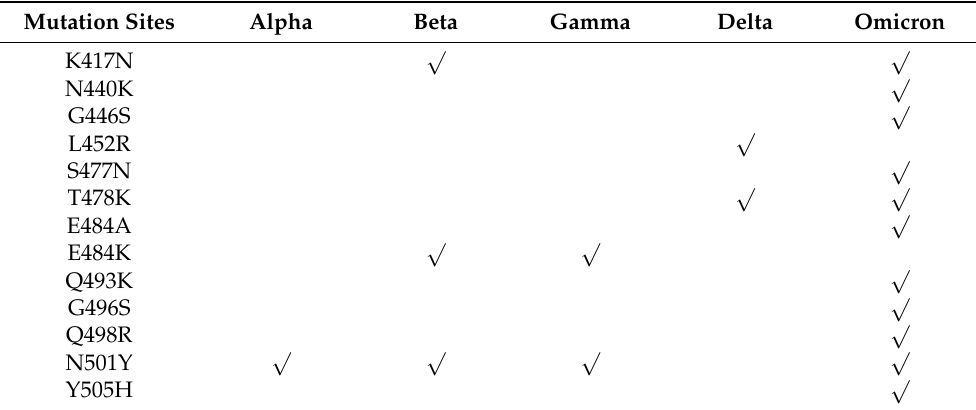
Table 1. Major single point mutations in Alpha, Beta, Gamma, Delta and Omicron variants of SARS-CoV-2 in the RBD that are studied in this work. Mutation Sites Alpha Beta Gamma Delta Omicron